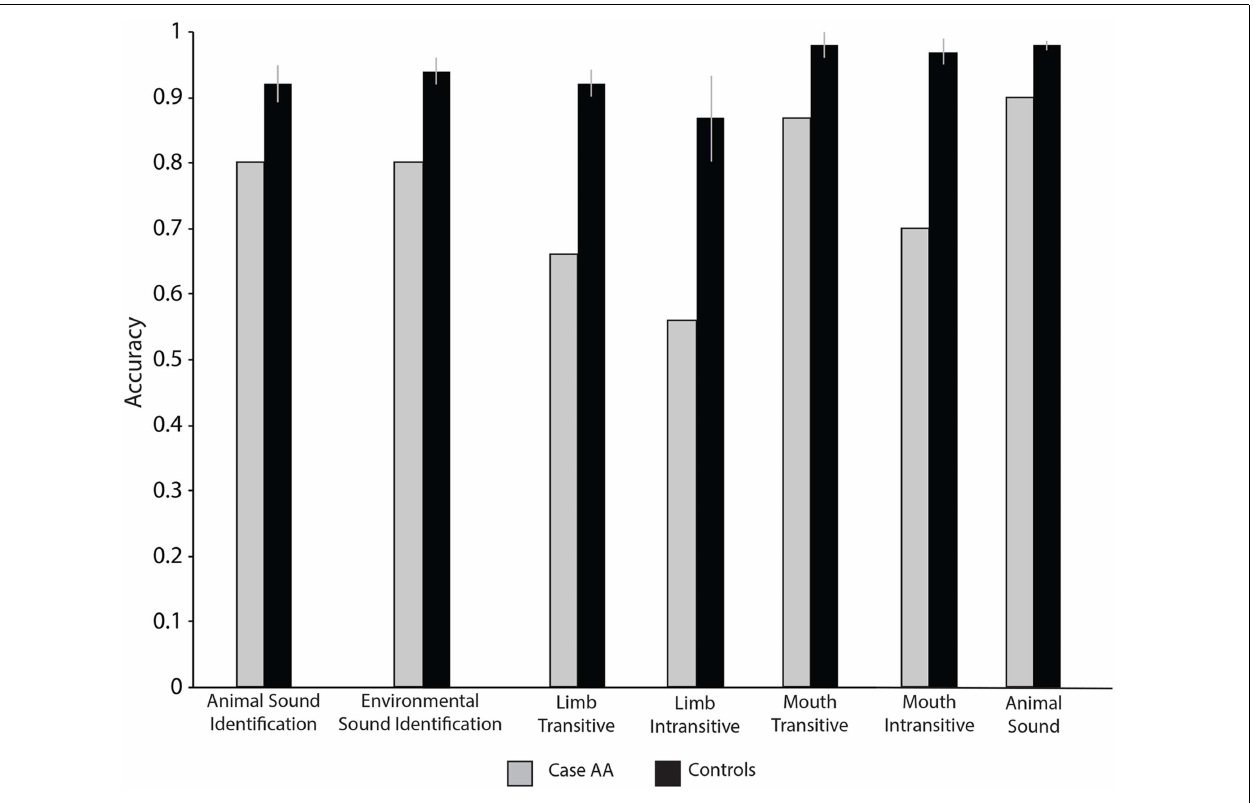
FIGURE 6 | CaseAA and controls’ accuracy when discriminating object and action